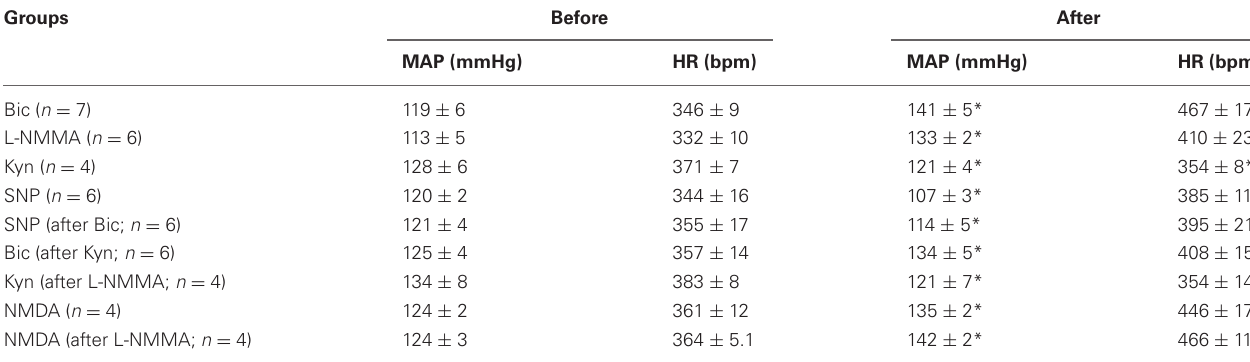
Table 1 | Mean arterial pressure (MAP) and heart rate (HR) before and after drugs microinjected in the PVN. Groups